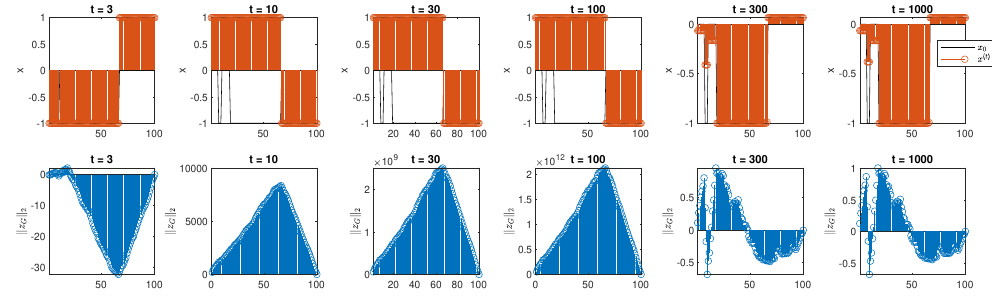
Figure 5 Trajectory of primal variable and dual variables for TV penalty. Here we investigate RP-CGM where θ = 3 / 4, ρ = 0 . 25, and p = 2. For stability, t 0 = 100. The ground truth x 0 contains 3 flips, and is otherwise smooth. As before, the goal is to fit x ( t ) to x 0 , using this group structure prior.